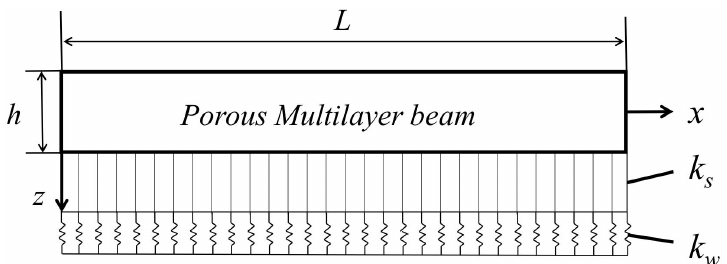
Figure 1. FG porous multilayer beam resting on an elastic